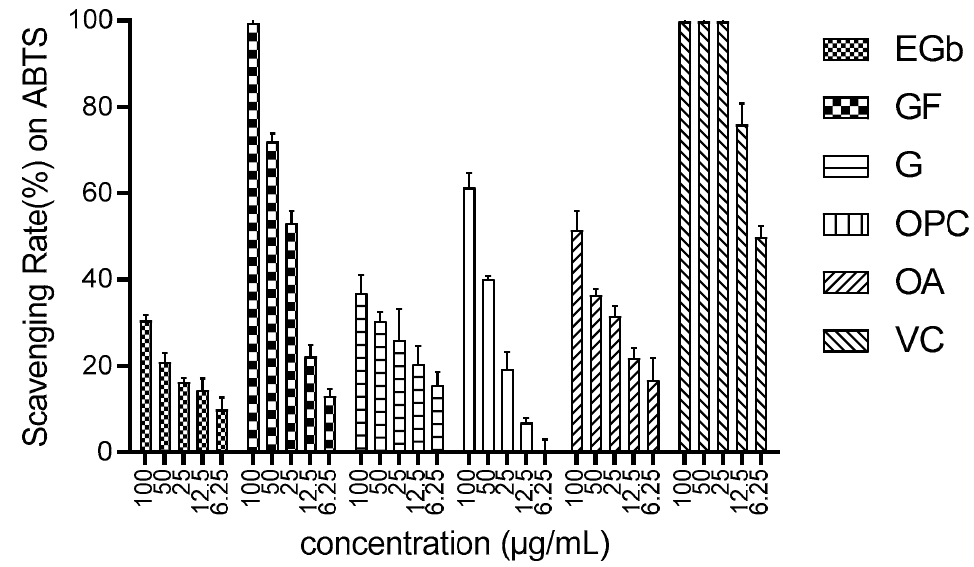
Figure 2. Scavenging effect of EGb functional components on ABTS free radicals. Table 3. The IC 50 value of ABTS radical scavenging from each functional component of EGb.